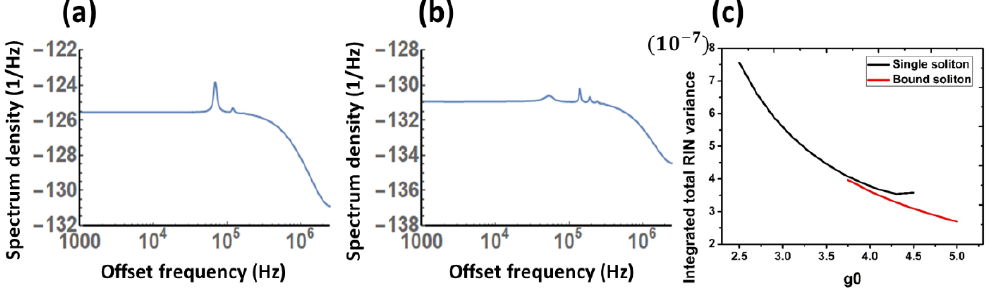
Figure 6. The calculated RIN spectra for ( a ) single-soliton state at g 0 = 2.5 and ( b ) bound-soliton state at g 0 = 5 within the span from 1 kHz to 2.5 MHz. ( c ) The integrated intensity noise variance versus g 0 within the same span.